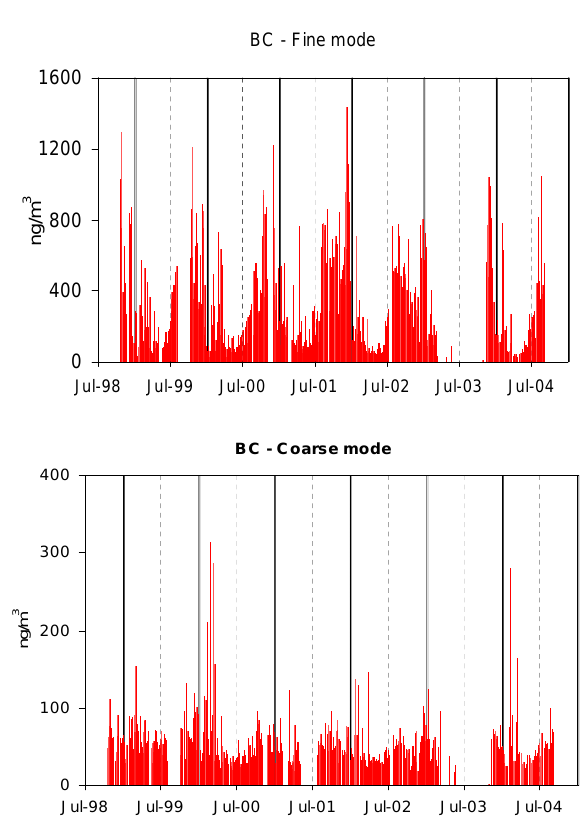
Fig. 4. The equivalent black carbon (BC E ) concentration observed in Balbina for (a) fine mode (top) and (b) coarse mode (bottom) during the same period presented in Fig. 2. Mean concentrations were 170 ± 180ngm − 3 for the fine mode and 50 ± 40ngm − 3 for the coarse mode. Note the increase in fine mode concentration dur- ing dry periods synchronized with the increase in fine particulate mass. This behavior is not observed in coarse mode, which is not influenced by the biomass-burning